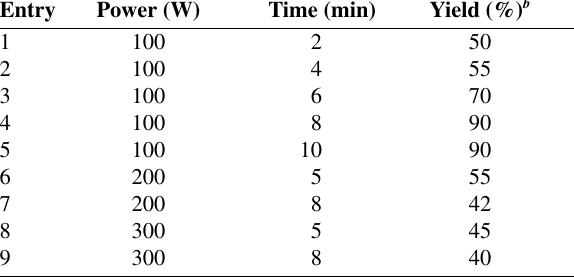
Table 2 . Optimization of microwave power